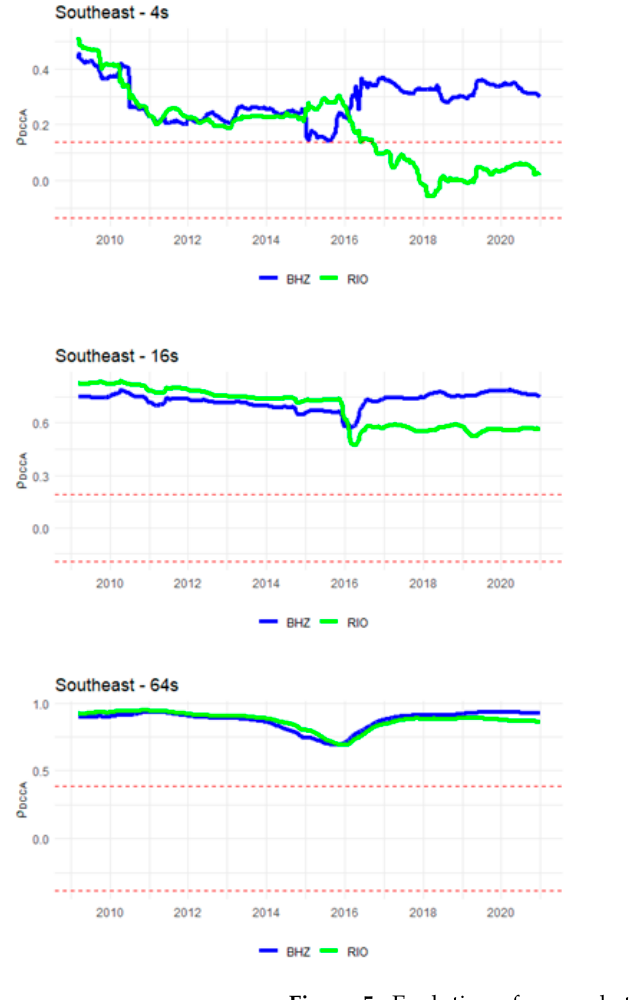
Figure 5. Evolution of ρ DCCA between the relative prices of S ã o Paulo and other capitals in the Southeast Region, with time scales of 4, 8, 16, 32 and 64 weeks, and moving window w = 250. Shaded lines are the upper and lower confidence intervals, in the sense that values between these are not statistically significant, according to the critical values of [66].